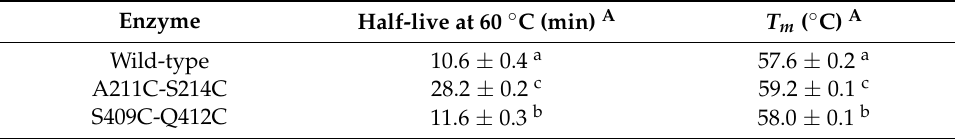
Table 3. Half-life at 60 ◦ C and T m of wild-type MFA ps and mutants.